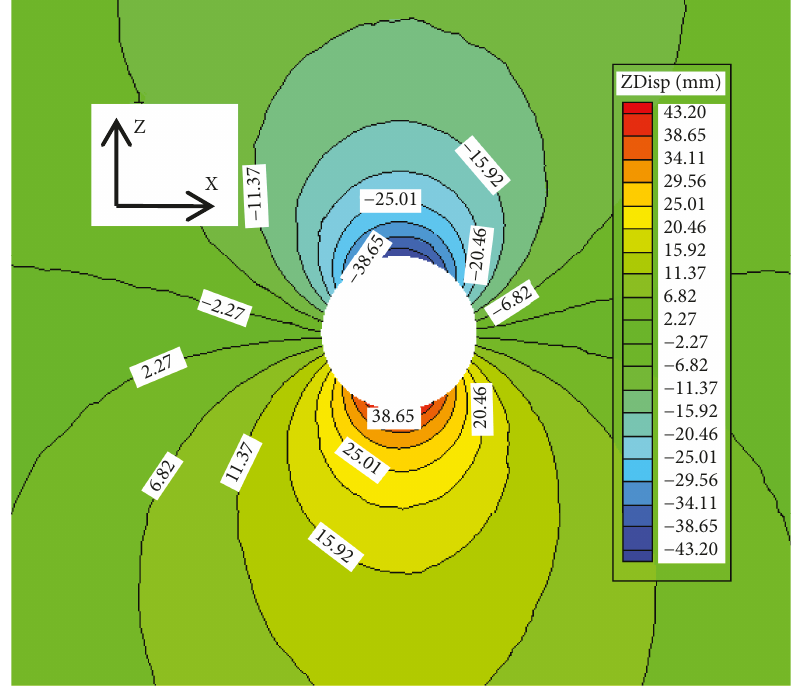
Figure 19: Displacement of section B-B along